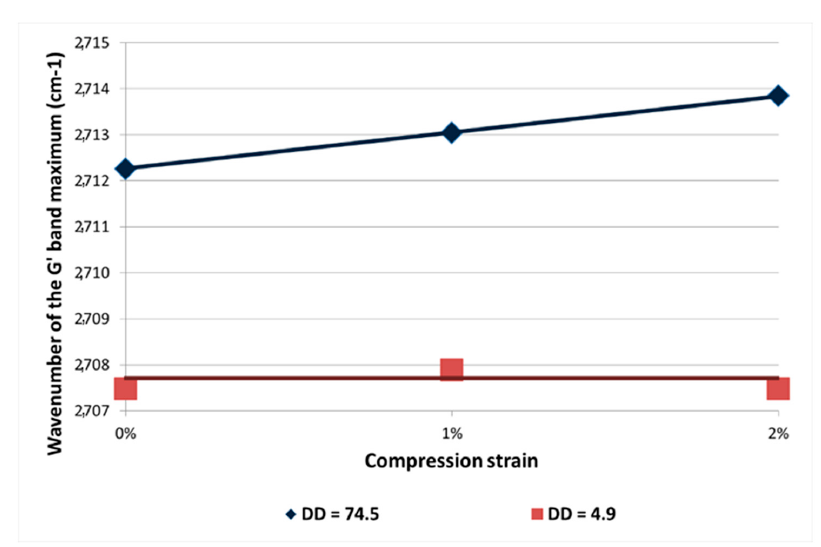
Figure 15. G’ band shift as a function of the compression strain of DGEBA / DDS / MWNT nanocomposite (0.7 wt %) and of two different dispersion states (DD = 4.9 and DD = 74.5).